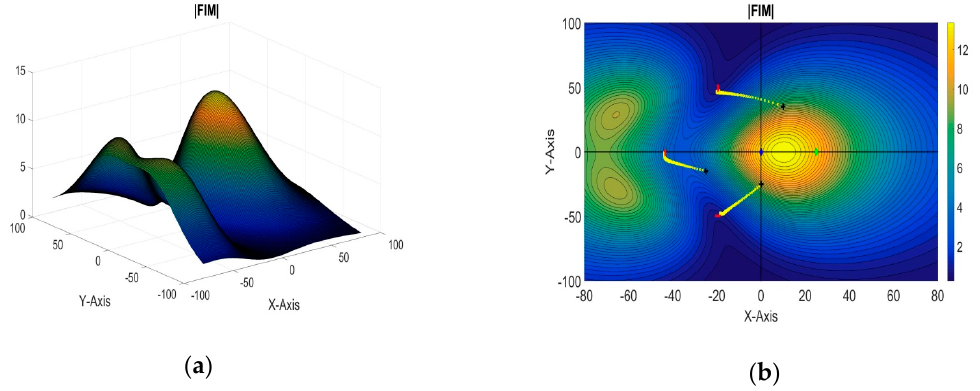
Figure 4. ( a ) Three-dimensional (3D) plot of the evaluation function (single target: CSP); ( b ) Two-dimensional (2D) contour plot of the evaluation function (single target: CSP).